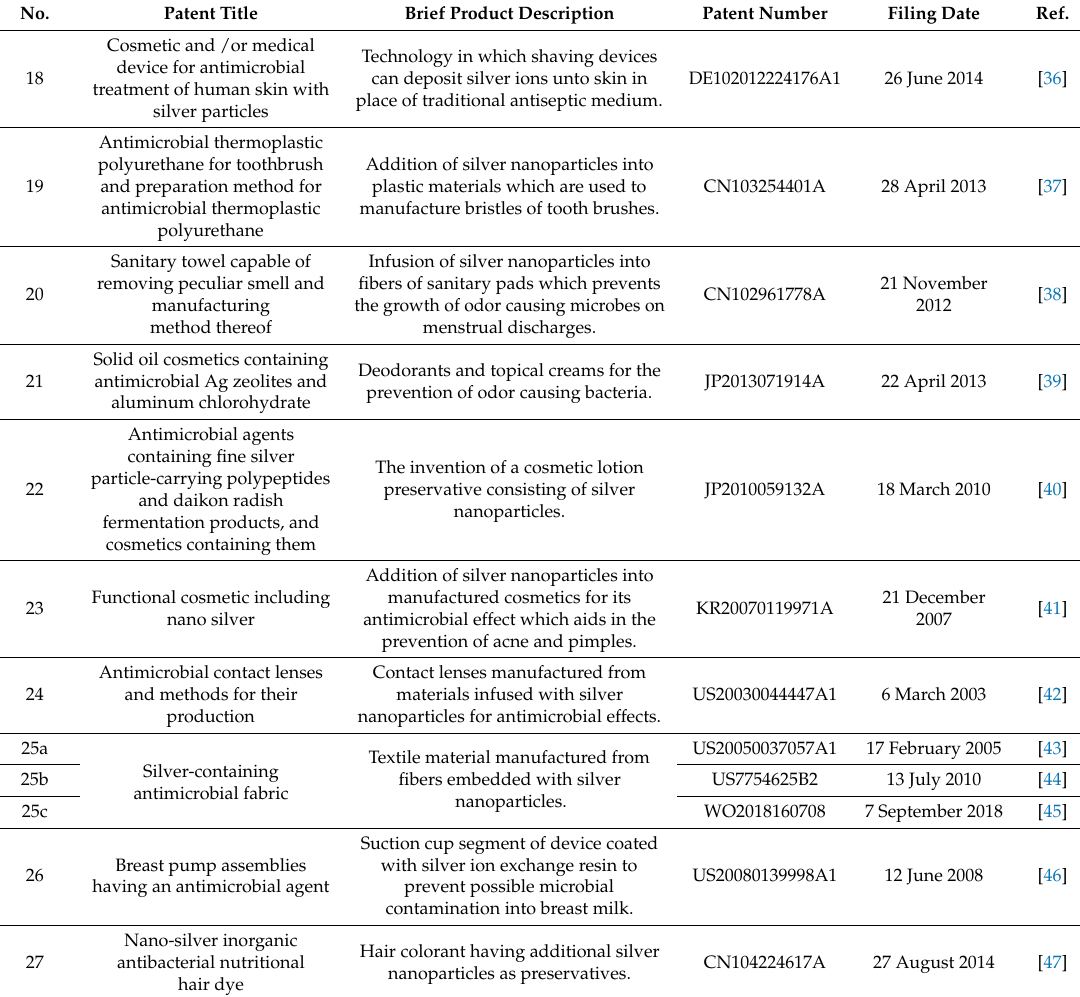
Table 2. List of patented personal-care products containing silver as an antimicrobial agent.